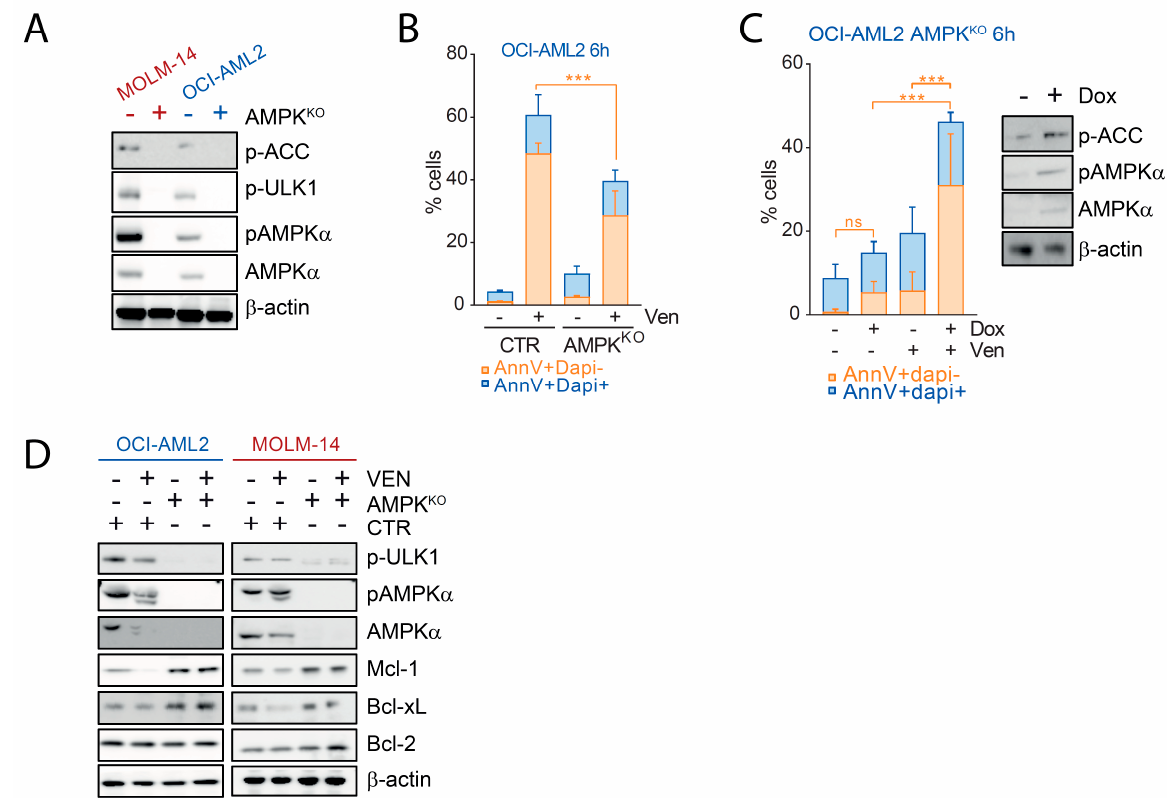
Figure 4. AMPK contributes to the pro-apoptotic activity of venetoclax in AML. ( A ) MOLM-14 and OCI-AML2 cells were transduced with either a control or a PRKAA1 CRISPR/Cas9 sgRNA targeting AMPK α 1 and submitted to Western blots using anti-phospho-ACC S79, -phospho-ULK-1 S555, -phospho-AMPK T172, anti-AMPK α , and anti- β -actin antibodies. ( B ) OCI-AML2 cells expressing (CTR) or not (AMPK KO ) AMPK were incubated with vehicle or 100 nM venetoclax for 6 h and processed for flow cytometry analysis of apoptosis using annexin V and DAPI staining. ( C ) AMPK KO OCI-AML2 cells were transduced with a vector allowing the expression of AMPK α 1 after the addition of doxycycline (Dox). Left panel: cells were incubated with vehicle or 100 nM venetoclax for 6 h and flow cytometry for annexin V and DAPI was performed. Right panel: Western blots were done using anti-phospho-ACC S79, -phospho-AMPK T172, -AMPK α , and – β -actin. ( D ) CTR or AMPK KO MOLM-14 and OCI-AML2 cells were incubated with vehicle or 100 nM venetoclax for 6 h and submitted to Western blotting using anti-phospho-ULK-1 S555, -phospho-AMPK T172, -AMPK α , -Mcl-1, -Bcl-xL, -Bcl-2, and anti- β - actin antibodies. Vertical bars indicate standard deviations. *** p < 0.001. 3. Discussion Venetoclax recently emerged as a breakthrough therapy in AML, inducing deep and long-lasting remissions when combined with low-dose cytarabine or hypomethylating agents in patients ineligible for intensive therapy [18]. Understanding the molecular and cellular consequences resulting from Bcl-2 inhibition is essential to design future thera- peutic strategies based on venetoclax in AML. In line with previous reports, we observed that venetoclax depleted the intracellular ATP pool in AML cells. As AMPK activity is governed by the intracellular AMP:ATP ratio, we hypothesized that venetoclax could ac- tivate AMPK, but surprisingly the opposite was observed. In AML cells sensitive to Bcl-2 inhibition, venetoclax induced a rapid decrease of AMPK phosphorylation and activity, due to a caspase-dependent degradation of AMPK α , β , and γ subunits. To investigate the role of AMPK in the early apoptotic response induced by venetoclax in AML, we depleted AMPK by CRISPR/Cas9 in AML cell lines [17,19].